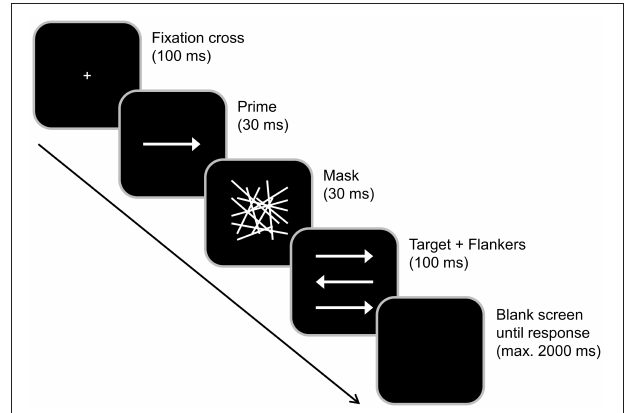
FIGURE 2 | Illustration of the Eriksen Flanker task. Each trial began with the presentation of two flanker stimuli both pointing either to the left or right. After 200ms, the target-stimulus was then presented in the center for 300ms and simultaneously switched off together with the flankers. Flankers and target pointed either in the same (compatible) or in the opposite (incompatible) direction. The subjects had to determine the direction of the target-stimulus (the central arrowhead) by pressing the left and right Ctrl-buttons. Compatible (75%) and incompatible stimuli (25%) were presented randomly. The response-stimulus interval was randomly varied between 900 and 1,300ms. task will be to use the right and left Ctrl buttons on the keyboard the last picture is pointing. Please press the left button with your